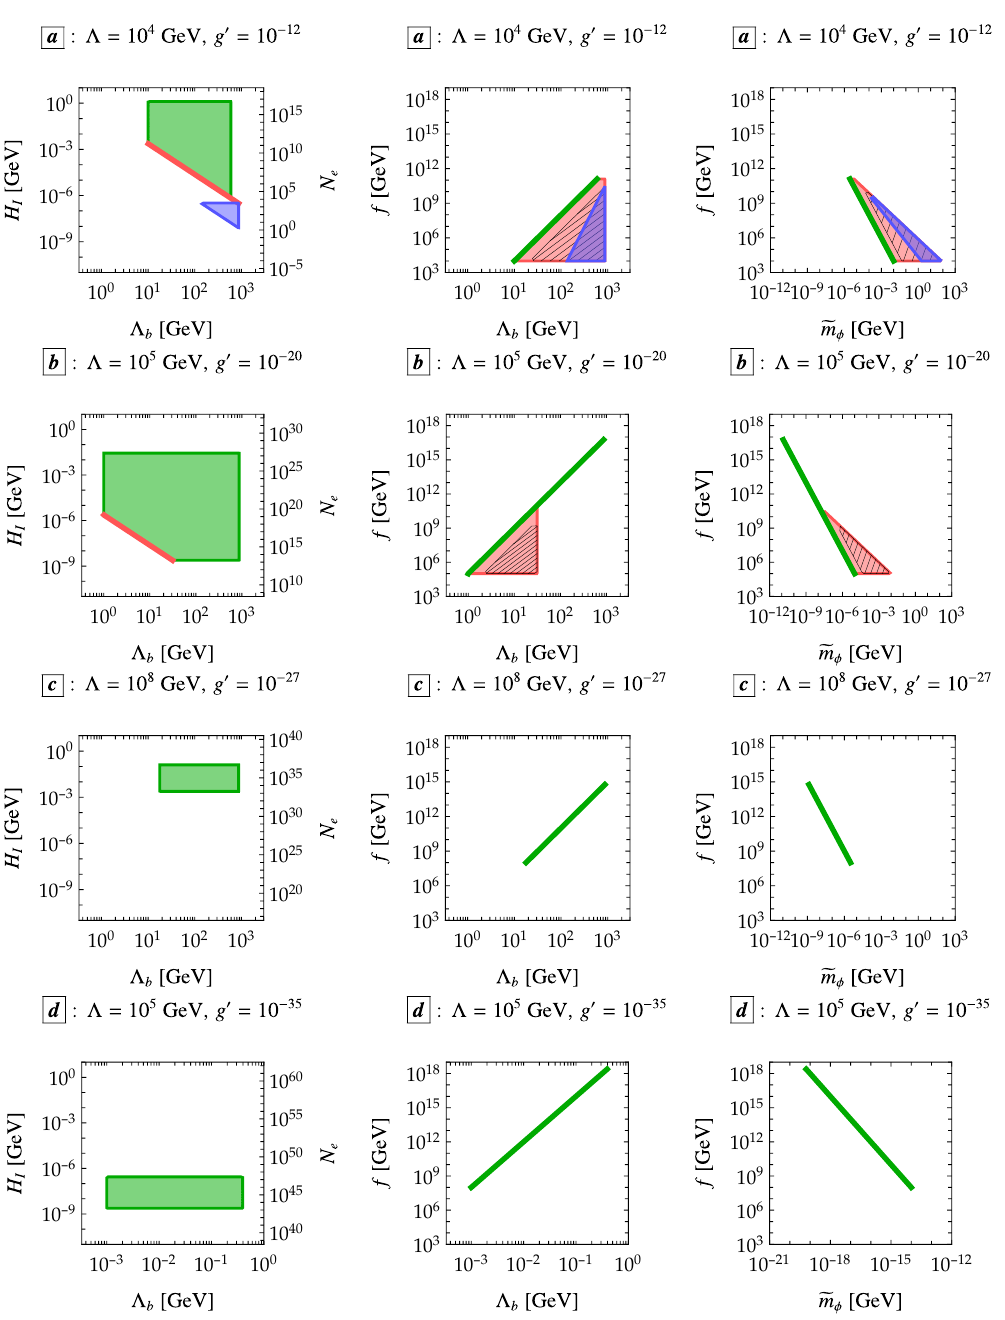
Figure 4 . Parameter space of the relaxion mechanism taking place with Higgs-dependent barriers, during in(cid:13)ation, where the relaxion is a subdominant component of the energy density of the uni- verse (non-QCD case of [1]), as described in section 3.1. Same color code as in (cid:12)gure 2. The hashed part of the red region corresponds to the case in which, in the ‘large barriers’ case, fragmentation is active and makes the relaxion stop in a shorter amount of time. Accurate predictions in this region are made harder by the action of two friction sources (see discussion below eq. (3.20)). For each benchmark point of (cid:12)gure 2 associated with the three stopping mechanisms de(cid:12)ned in section 3.1, we show the corresponding distinct regions in the ((cid:3) b , H I or N e ), ((cid:3) b , f ), and (